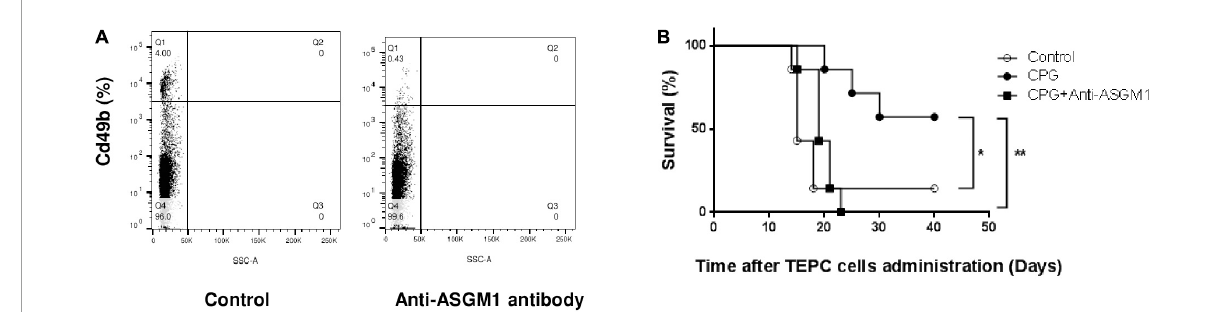
FIGURE2 Role of innate lymphoid cytotoxic cells in toll-like receptor (TLR)9-mediated protection against plasmacytoma growth. (A) Flow cytometry analysis of CD49b+ cells in pooled spleen cells from 2 BALB/c mice with and without treatment with 2 mg anti-ASGM1 antibody. Experiment representative of two independent experiments. (B) Survival of groups of BALB/c mice ( n = 7) either mocked-treated (open circles) or treated only with CpG-ODN (closed circles), or with CpG-ODN and anti-ASGM1 treatment (closed squares), was monitored daily after i.p. administration of TEPC.1033.C2 cells. Experiment representative of three independent experiments. * P = 0.0153 and ** P = 0.0015 by Log-rank (Mantel–Cox) test.